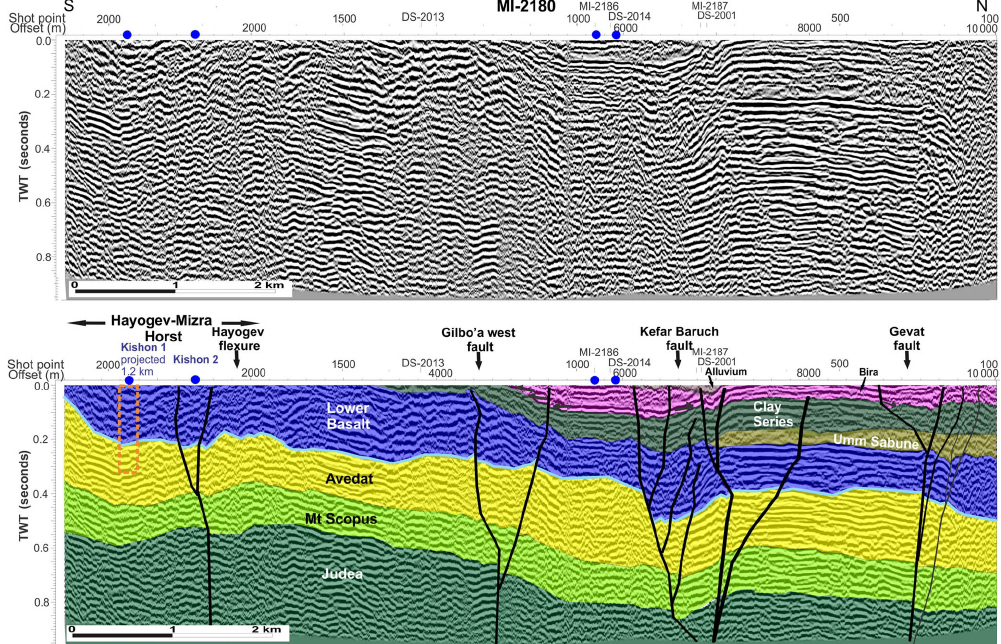
Figure 8. Multichannel seismic reflection profile line MI-2180. Kefar Baruch basin (B2) and Hayogev-Mizra horst (HMH) are sheared by faulting and folding. Vertical offset alongside folding on fault branches deforms the Clay Series, Umm Sabune, and Bira formations. Gevat fault suggests a horizontal offset due to its near-vertical fault plane and 1km wide flexures (see also Fig. 11). The thick Lower Basalt Formation on the south suggests a volcanic source in the HMH area (see also Fig. 10). This profile cuts the primary deformation zone and its uplifted southern shoulders – HMH. Celeste horizon – RTS. Orange dashed rectangle – projected location of the Kishon 1 well. Arrows depict onlap of the Bira Fm. on the Clay Series. Vertical exaggeration: ×